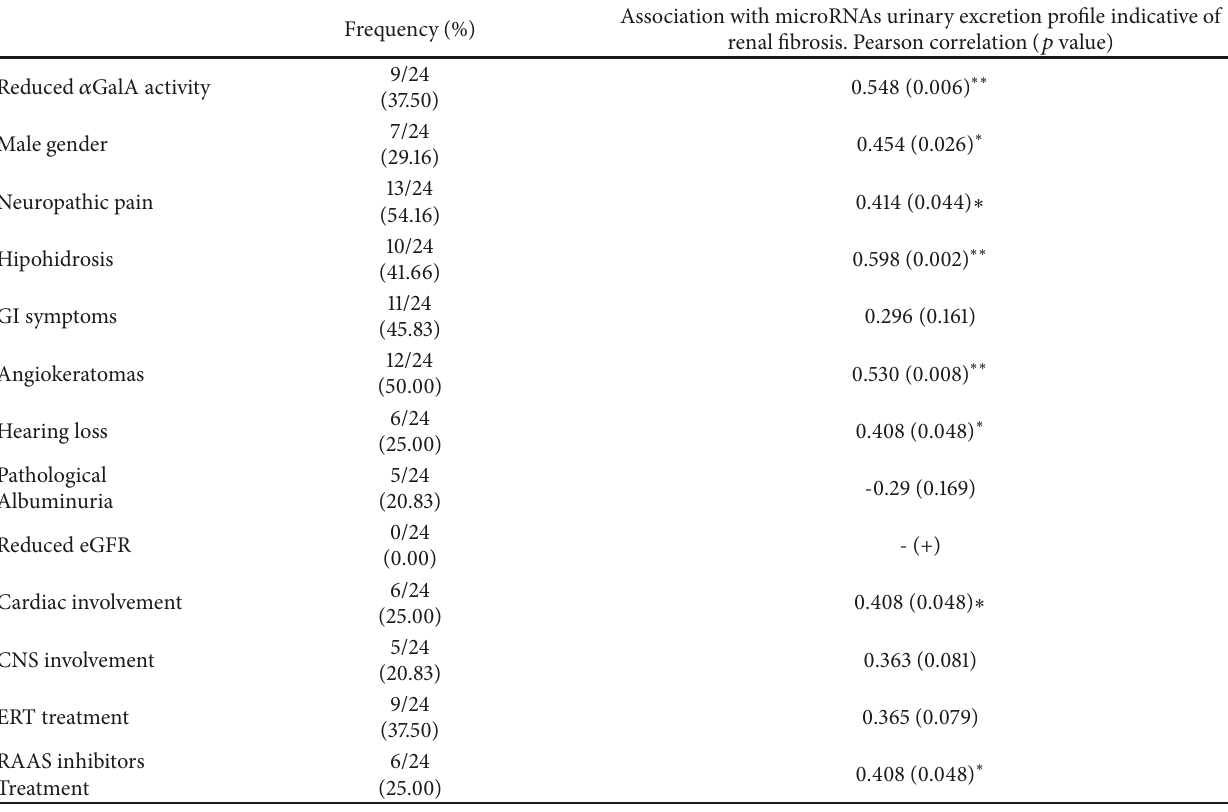
Table 2: Frequency of clinical manifestations and association with urinary microRNAs excretion profile indicative of renal fibrosis in Fabry disease